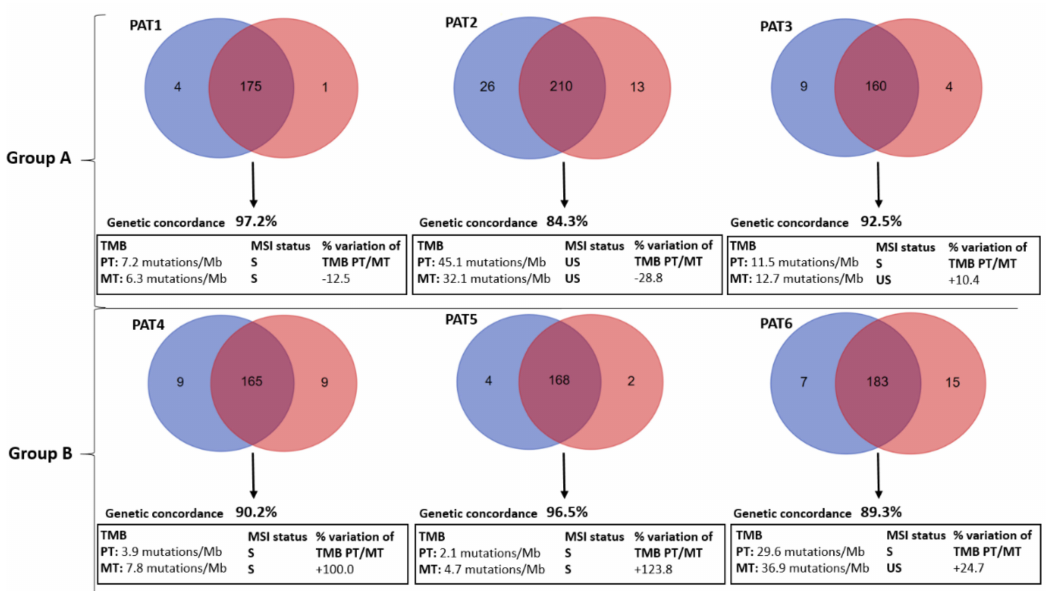
Figure 1. Venn Diagrams with genetic concordance, tumor mutation burden (TMB) and microsatellite instability (MSI) status with percent variation of group A (PAT1, 2 and 3) and group B (PAT4, 5 and 6) patients. Mb: Mega-bas; MT: Metastatic Tumor; PAT: Patient; PT: Primary Tumor. Blue circles represent PT genes’ mutations versus red circles MT genes’